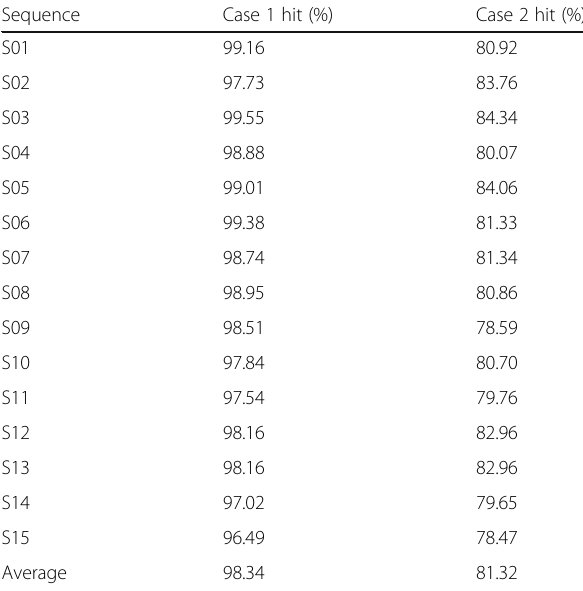
Table 7 Hit-rate analysis of the proposed method